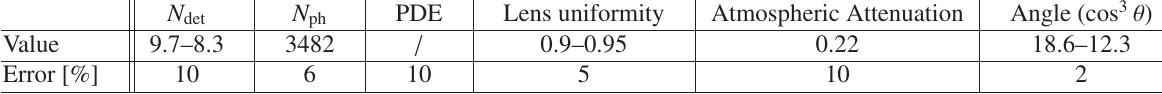
Table 1: List of the obtained parameters of the flasher and the quadratic sum of the errors